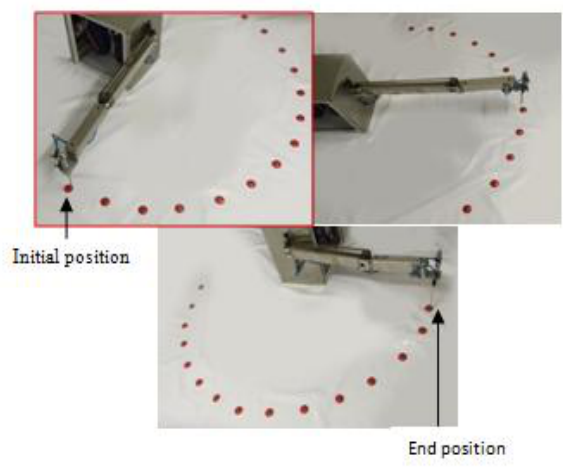
Fig. 15. The First Practical (Actual) Motion